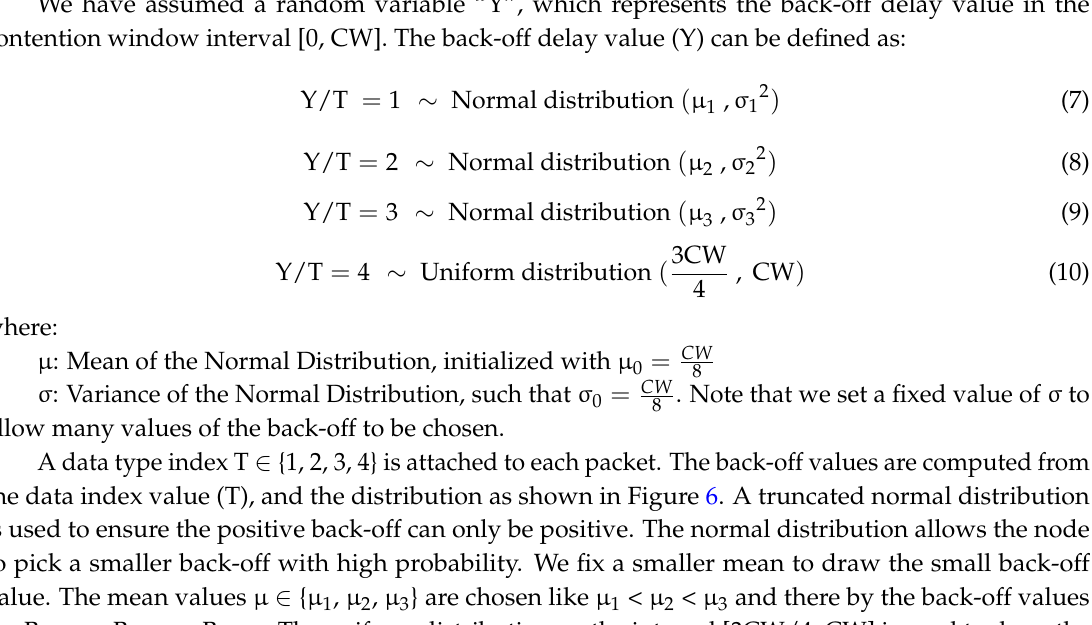
Table 2. Data types with priority assignment and access requirements.